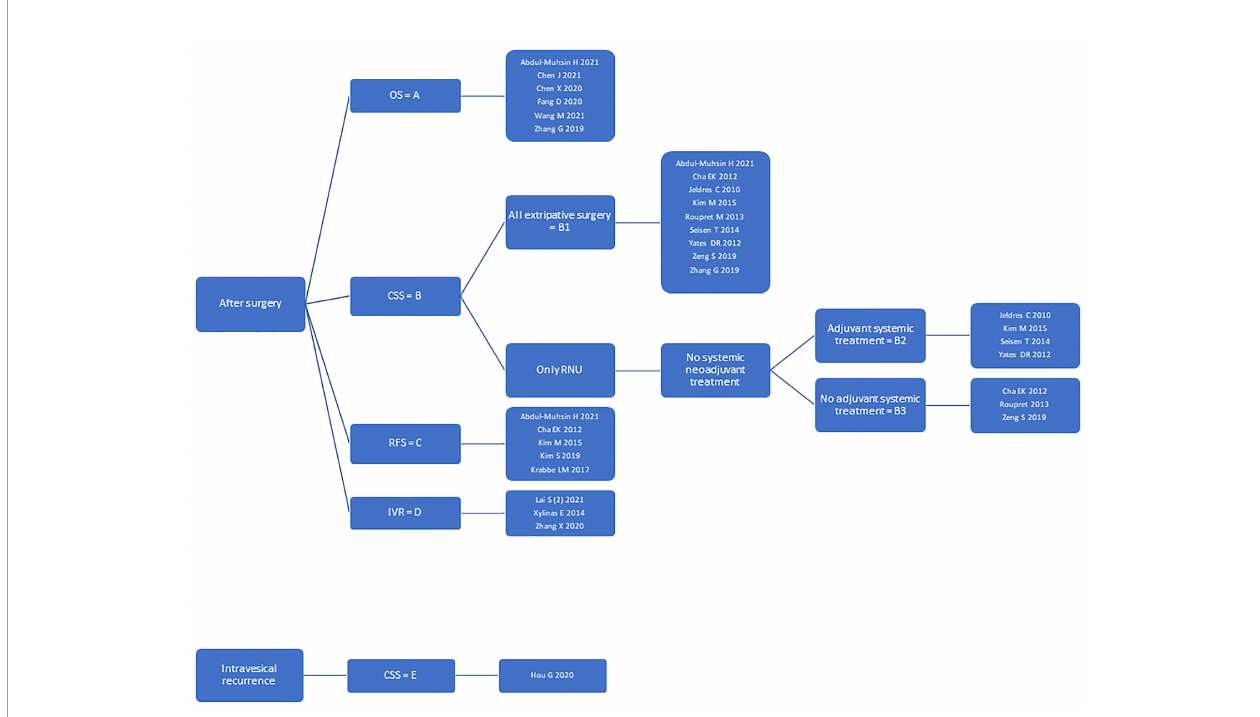
FIGURE 2 | This fi gure shows the nomogram group strati fi cation process. Further, it lists all nomograms within each